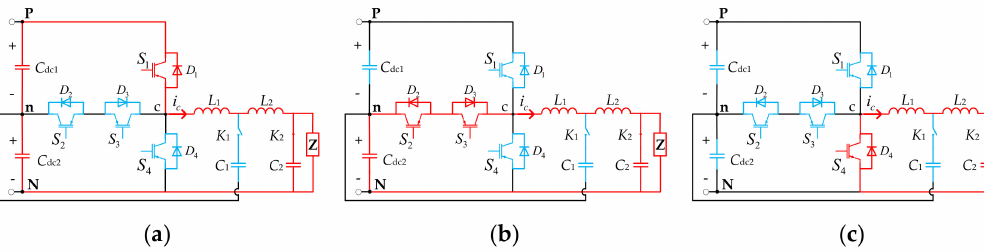
Figure 4. DC mode T-type three-level converter current loop. ( a ) + 2 level; ( b ) + 1 level; ( c ) zero level.